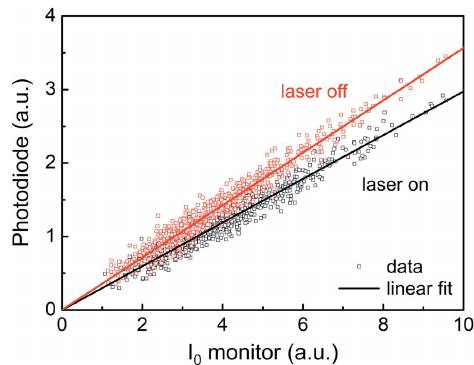
Figure 2 Correlation between the I 0 monitor (QBPMs) and photodiode signals (X-ray fluorescence) obtained from an aqueous solution of tris(bi- pyridine) ruthenium(II) chloride ([Ru(bpy) 3 ] 2+ ) at 2840.5 eV with (black squares) or without (red squares) the pump laser and their linear fits. QBPM: quadruple beam-position monitor.